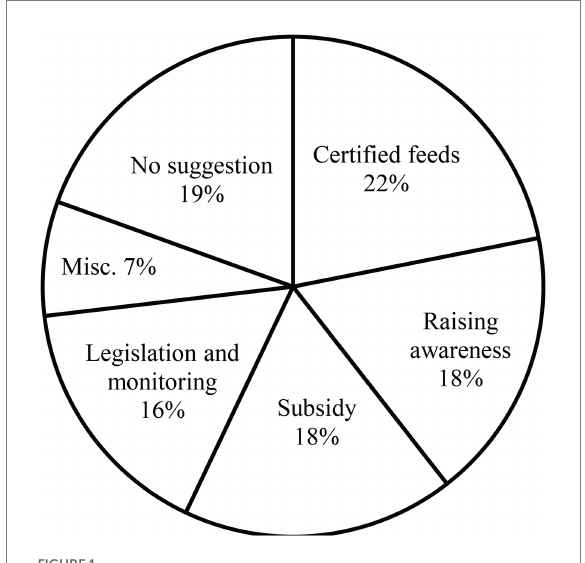
FIGURE 1 Farmer’s suggestions regarding aflatoxin